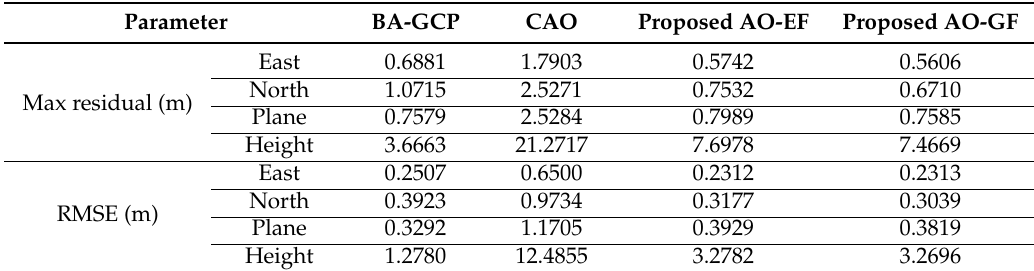
Table 5. The plane and height RMSE of the Taian dataset obtained by the classical method and the proposed